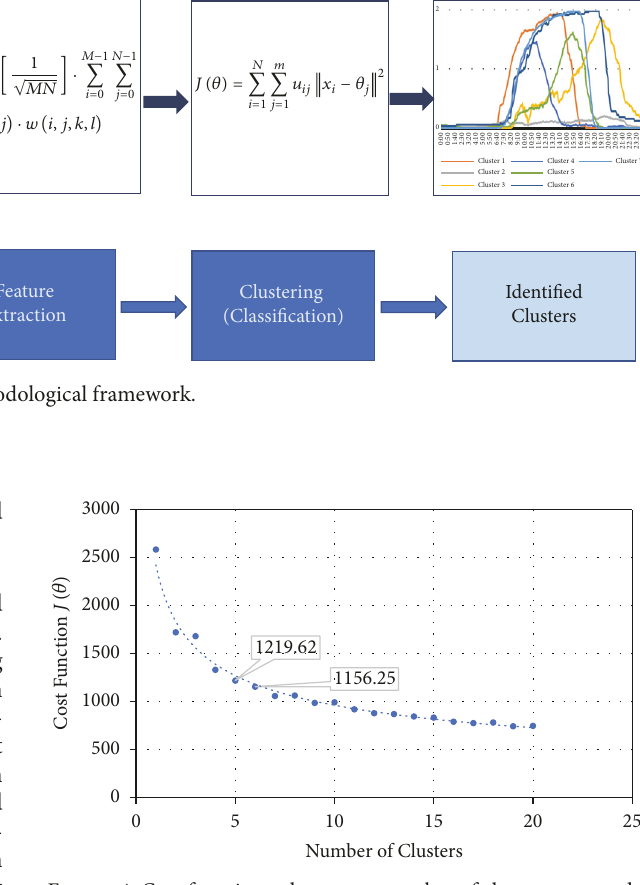
Figure 4: Cost function value versus number of clusters assumed a